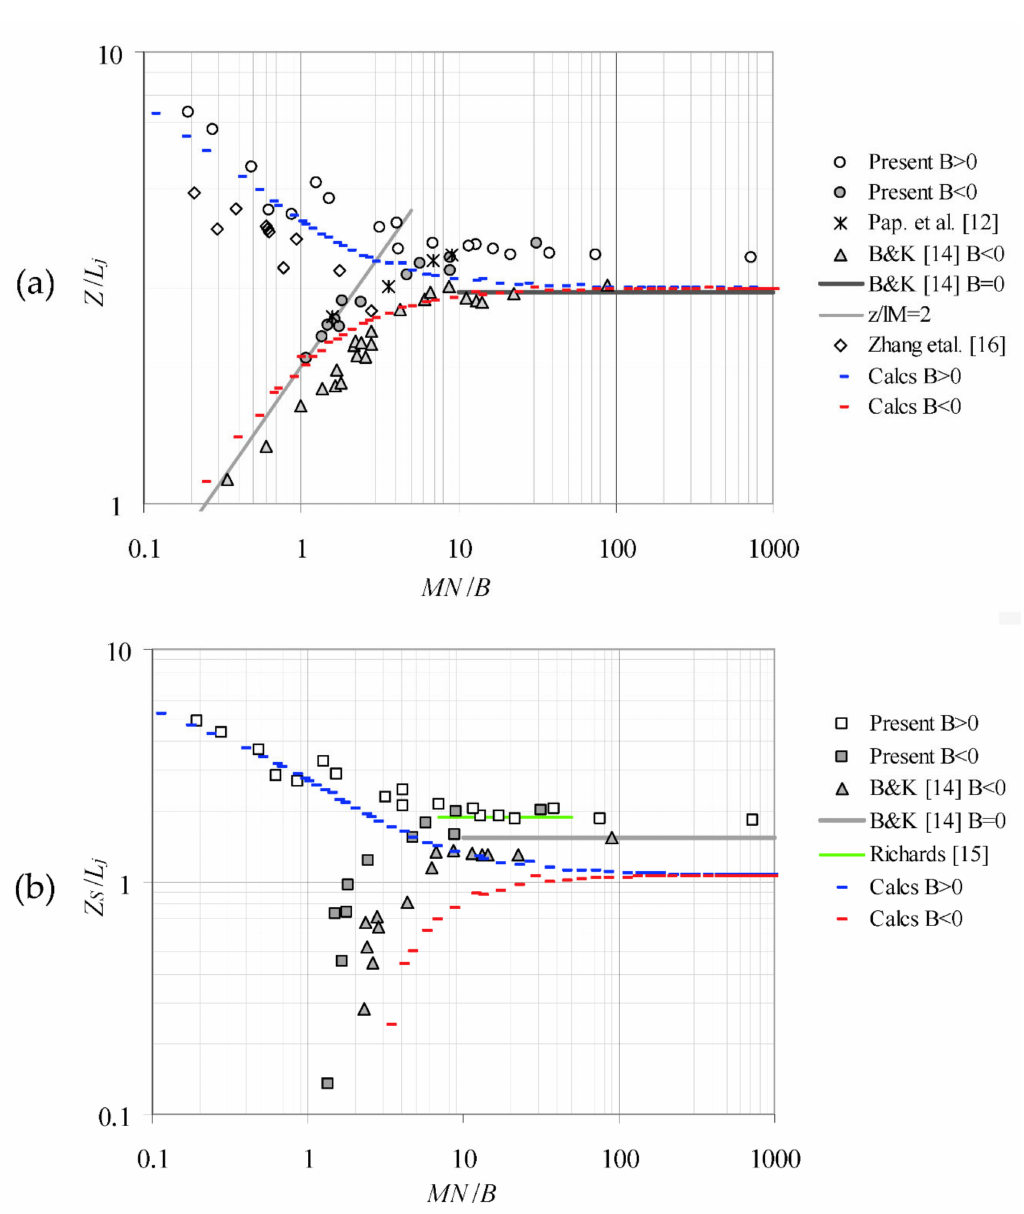
Figure 4. ( a ) Normalized terminal rise height Z / L j and ( b ) spreading elevation Z S / L j (bottom) versus MN / B